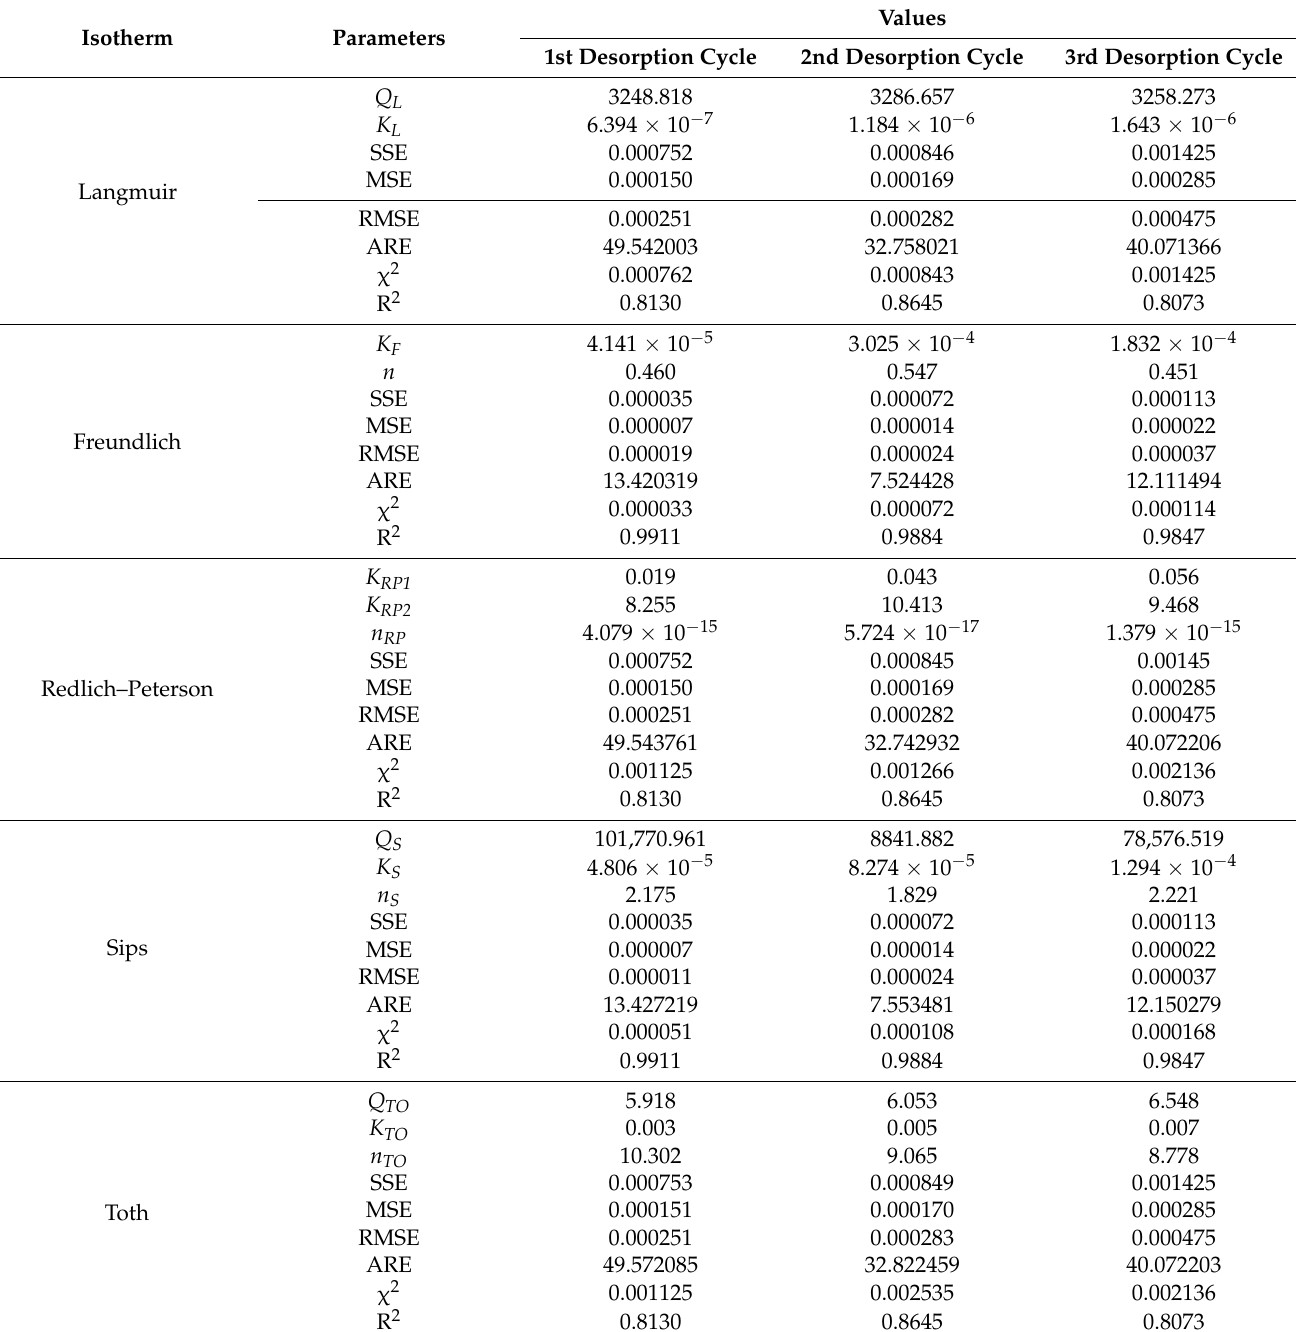
Table 4. Equilibrium isotherm parameters and statistical functions of RB desorption from